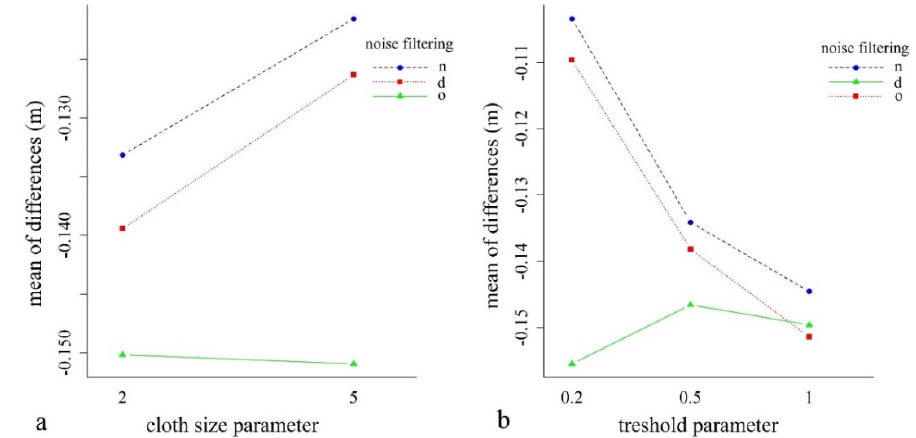
Figure 5. Mean differences (m) between the cloth size ( a ) and the threshold ( b ) parameters according to the noise filtering (d: surface distance-based, n: neighborhood distance-based filtering, o: original point cloud).